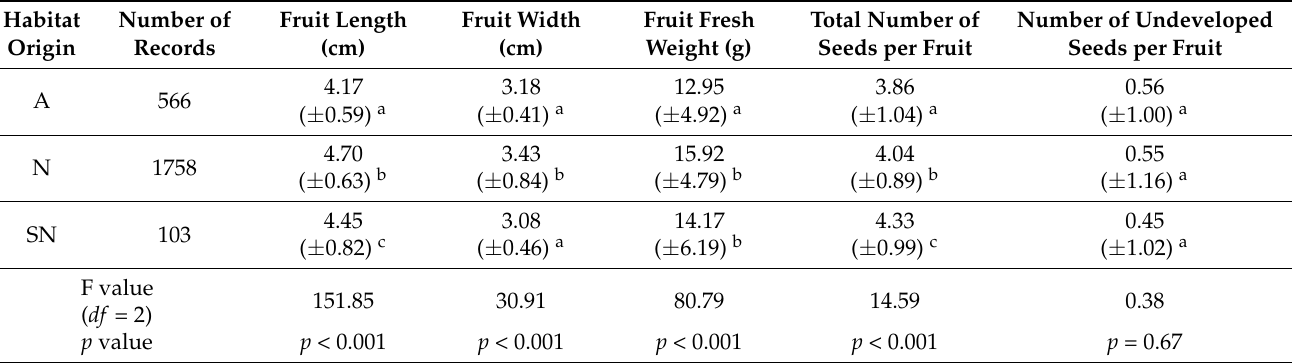
Table 1. The fruit and seed traits (mean ± SD) of Echinocystis lobata in anthropogenic (A), semi- natural (SN), and natural habitats